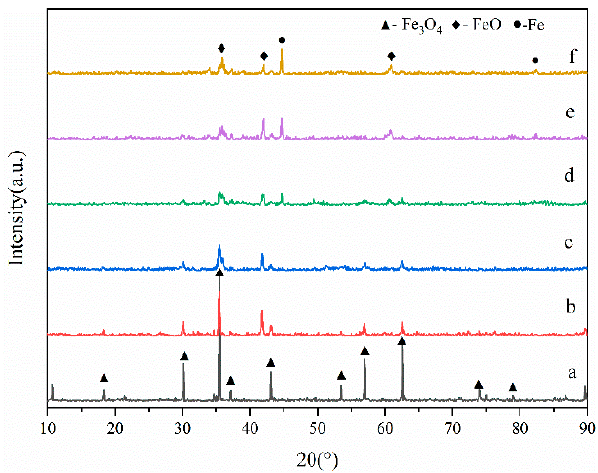
Figure 11. XRD patterns of Fe 3 O 4 samples, ( a ) 700 °C ; ( b ) 900 °C ; ( c ) 1000 °C ; ( d ) 1100 °C ; ( e ) 1200 °C ; ( f ) 1300 °C .